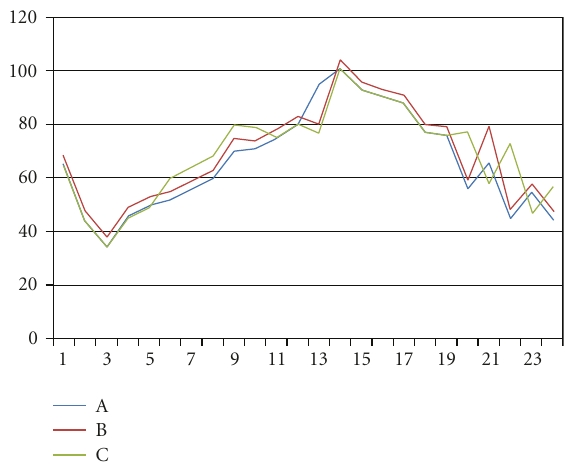
Figure 4: Examples of hourly market price